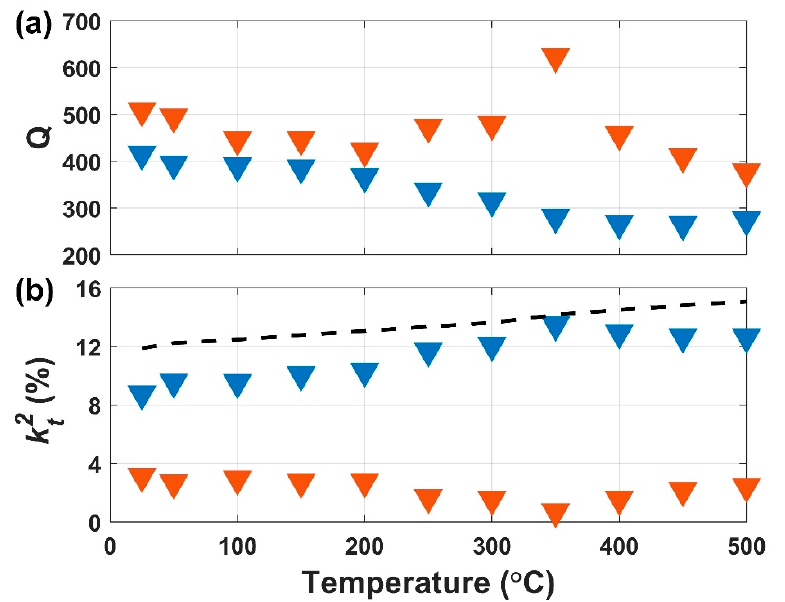
Figure 7. Extracted Q ( a ) and k t 2 (%) ( b ) as a function of temperature. Mode A and B are repre- by blue and orange triangles, respectively. The total k t 2 (sum of both modes) is represented by the sented by blue and orange triangles, respectively. The total k t2 (sum of both modes) is represented by the dashed black line. dashed black